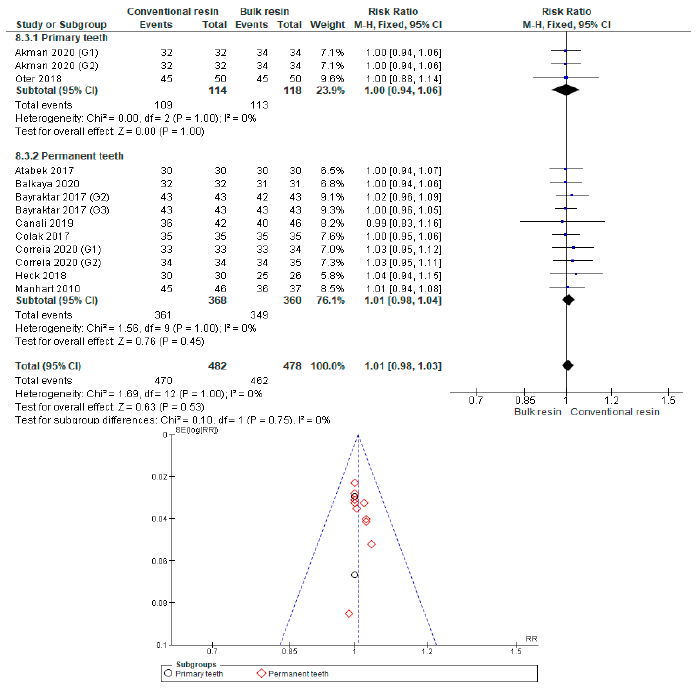
Figure A36. Proper Anatomical Form: Conventional Resin versus Bulk Resin According to Type of Restoration.